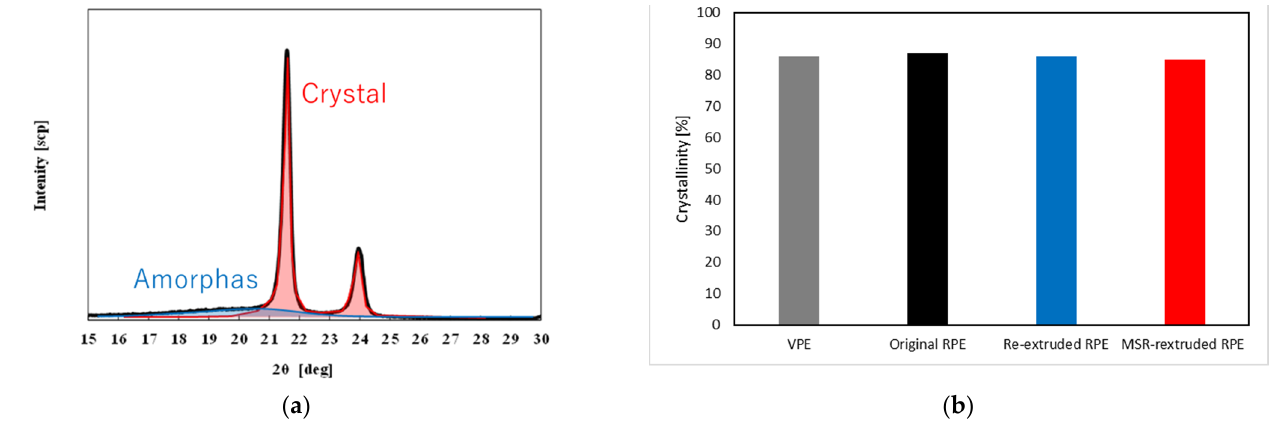
Figure 7. ( a ) Typical XRD patterns and ( b ) crystallinities of the (from left to right) virgin polyethylene (VPE), original recycled polyethylene (RPE), re-extruded RPE, and molten resin reservoir (MSR) re-extruded RPE moldings shown in grey, black, blue, and red bars, respectively.